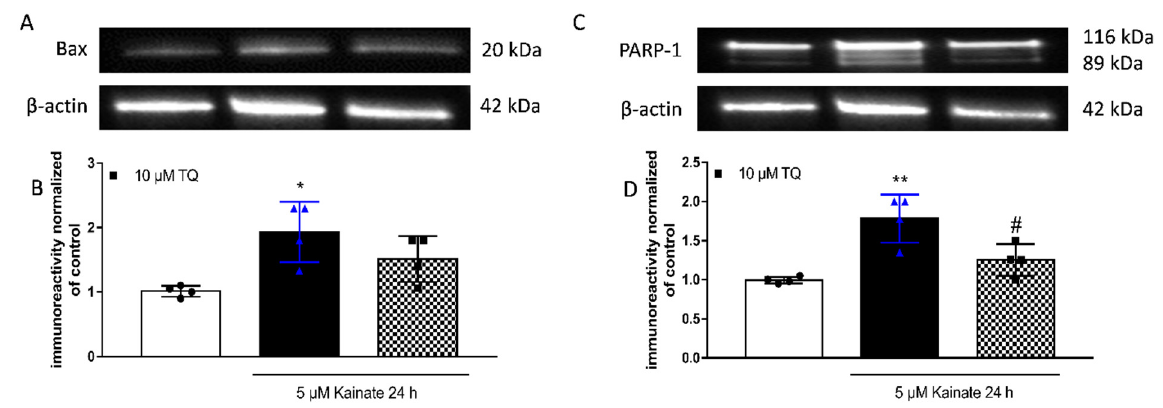
Figure 4. Effects of TQ on Bax and PARP-1 in slices exposed to KA. Slices were exposed to the KA (5 µ M for 24 h) and then processed for WB. TQ was added to the incubation medium during KA exposure. ( A , C ): Representative blots for Bax or PARP-1 or β -actin. ( B , D ): Quantitative analysis of immunoreactive bands, showing that TQ is able to reduce KA-induced enhancement in PARP-1 expression levels while having no effects on Bax. Dot blots show the results of four experiments from independent slice preparations and each dot is the pool of four slices. * p < 0.05 and ** p < 0.01 vs. CRL, # p < 0.05 vs. kainate. (ANOVA + Tukey’s w -Test).